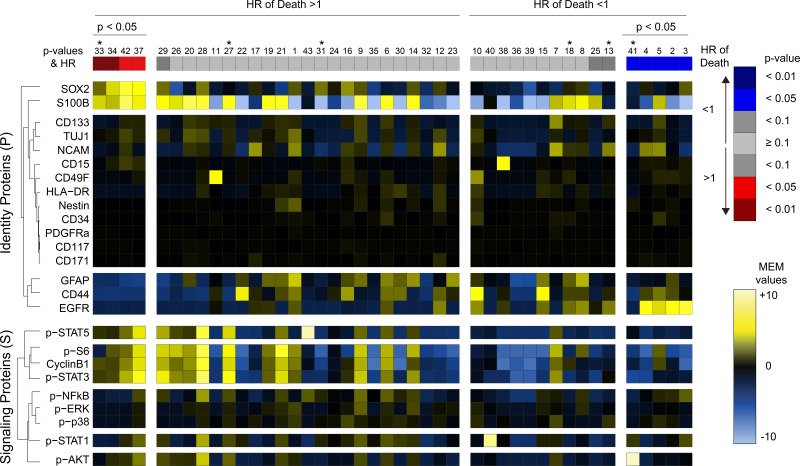
Glioblastoma cell subsets showed differential enrichment of identity proteins and phosphorylated signaling effectors.Forty-three glioblastoma cell subsets automatically identified by FlowSOM are arranged according to their associations with overall survival (HR >1, left; HR <1, right) and statistical significance of that association (p-values). The heatmap represents the MEM values of glioblastoma cell subsets (columns). GNP cells are labeled in red, while GPP cells are labeled in blue. Hierarchical clustering was performed based on MEM values and is depicted on the left of the heatmap for measured features. HR = hazard ratio of death. Asterisks (*) above indicate that clusters are not stable (F-measure of <0.5 or phenotypes identified in less than 50% of cell subsampling runs).